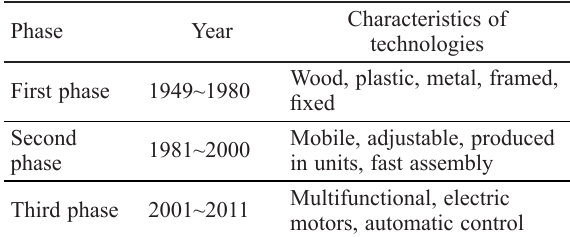
Table 9. Technology development of shading